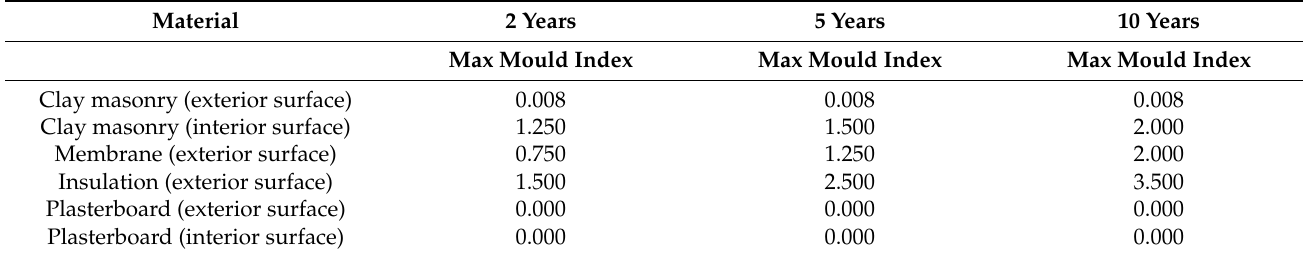
Table 12. Mould growth simulation results for the 7-star clay masonry veneer wall—southern orientation.